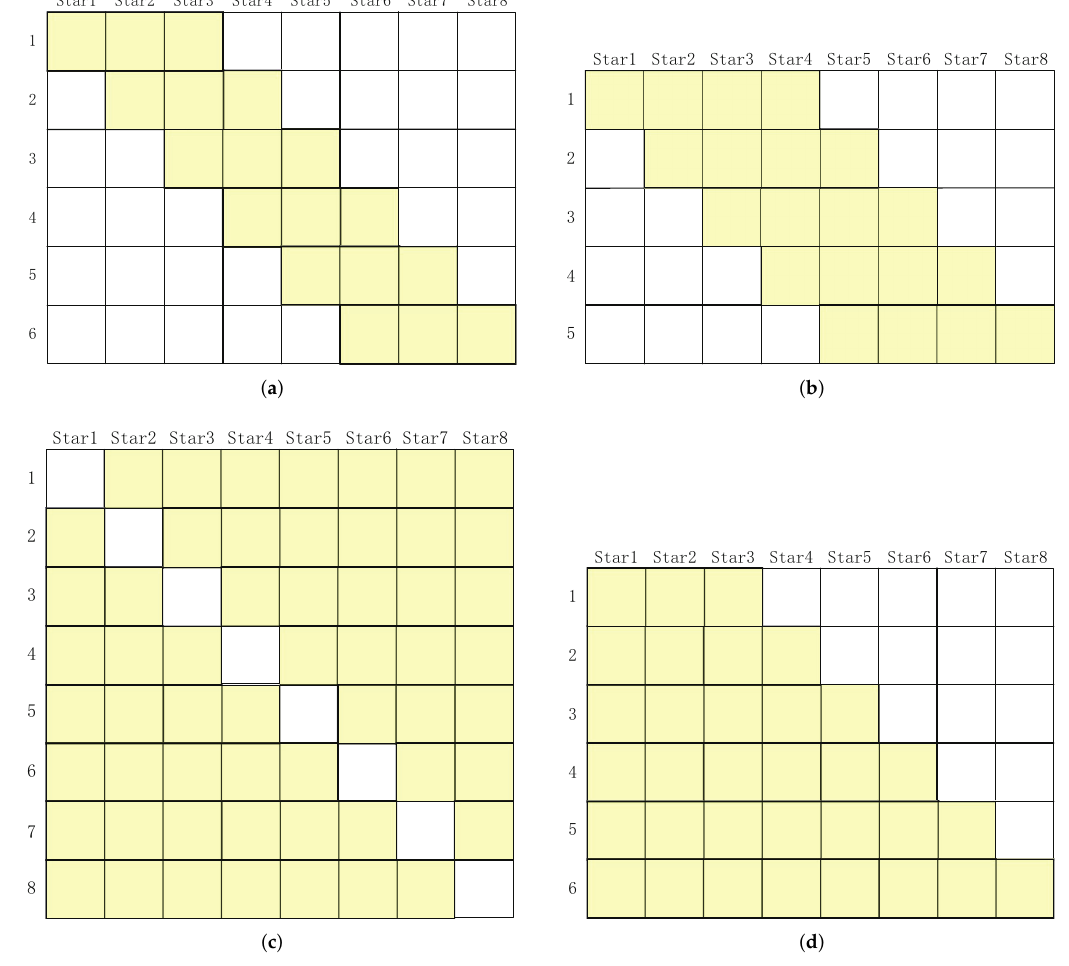
Figure 2. The schematic diagram of the combination models. ( a ) Model-1, ( b ) Model-2, ( c ) Model-3, and ( d ) Model-4.